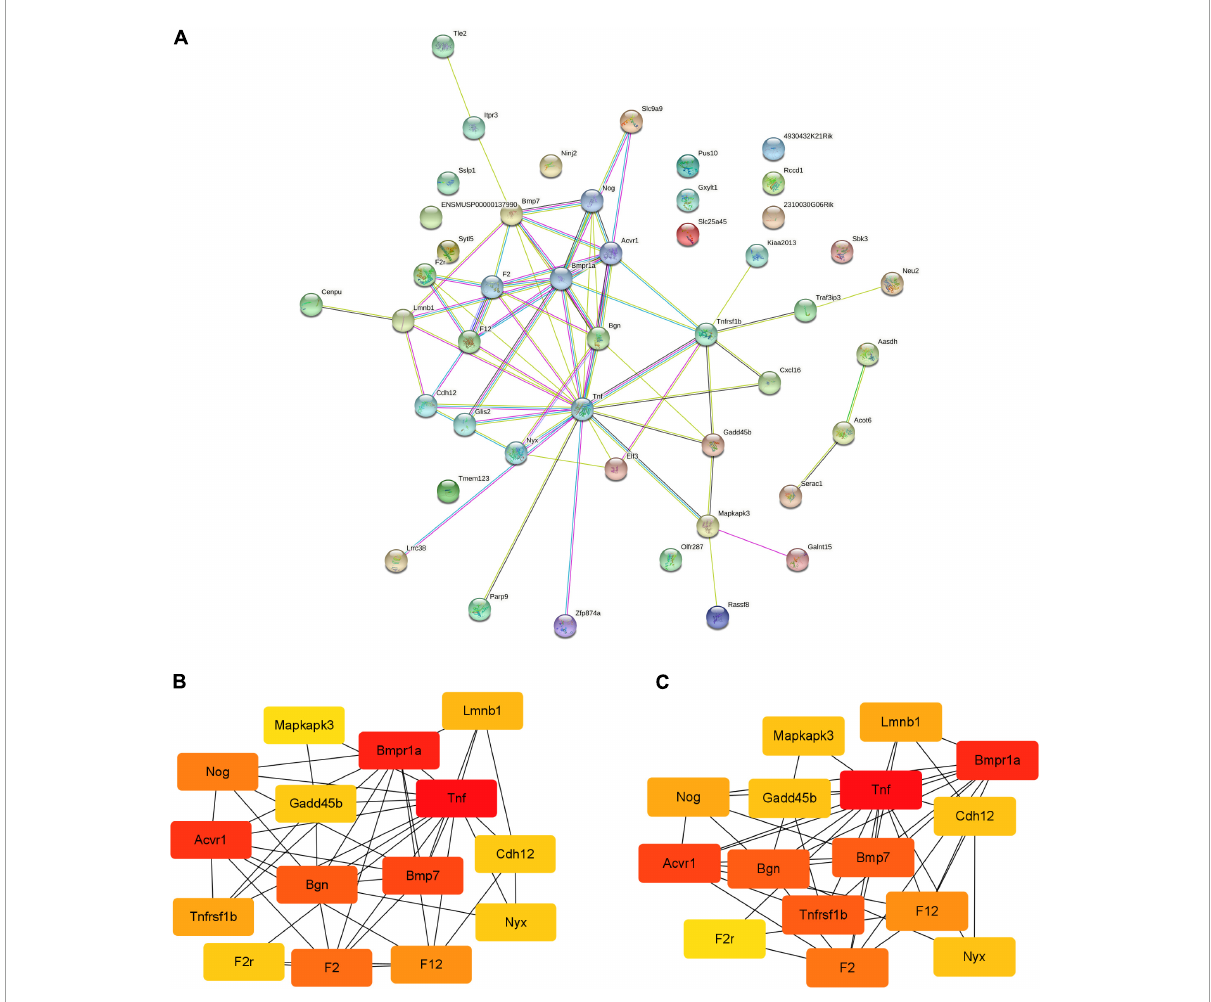
FIGURE4 The PPI networks of DEGs and modules. (A) PPI network analyzed by STRING database; (B,C) the top 15 genes selected according to the MCC and degree method. PPI, protein-protein interaction; DEGs, differentially expressed genes; MCC, maximal clique